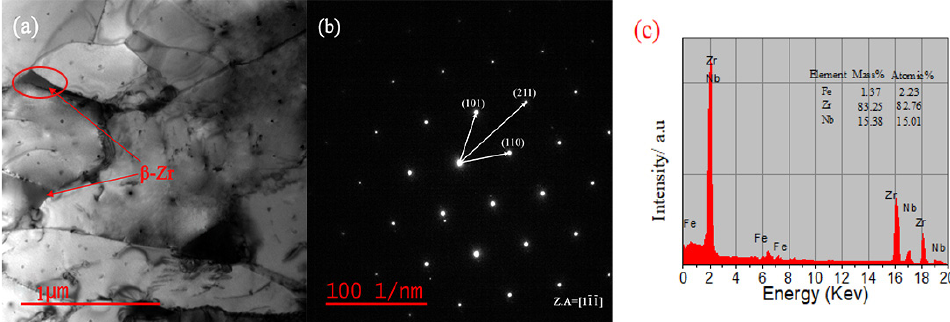
Figure 6. 715 °Cquenched sample: ( a ) BF-TEM image ( b ) SAED ( c ) EDS.